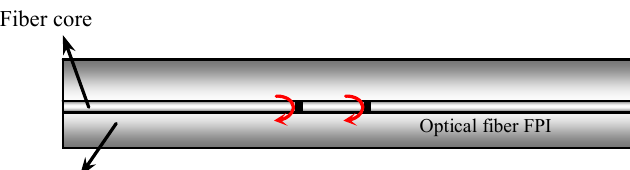
Figure 1. Schematic of an optical fiber based